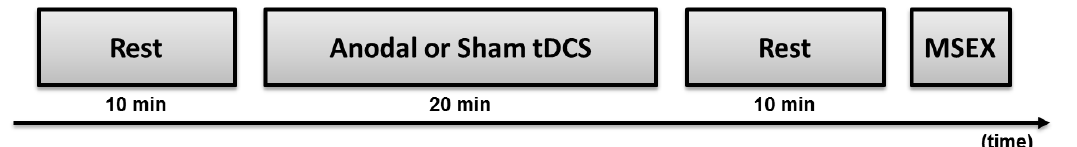
Figure 1. Study design overview. tDCS = Transcranial direct current stimulation; MSEX = Maximal strength exercise.